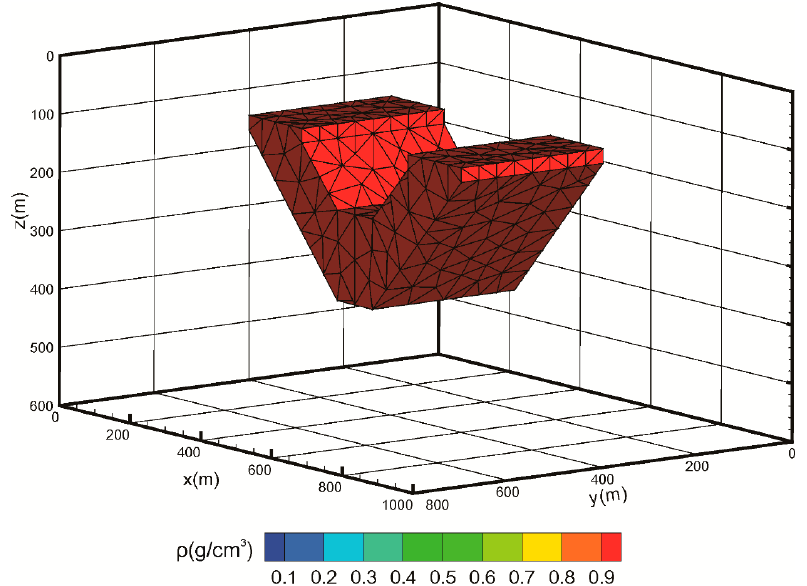
Figure 3. A V-shaped structure with a relative density of 1 g/cm 3 on unstructured grids. The inversion results of two weighting strategies without regularization terms ( λ =